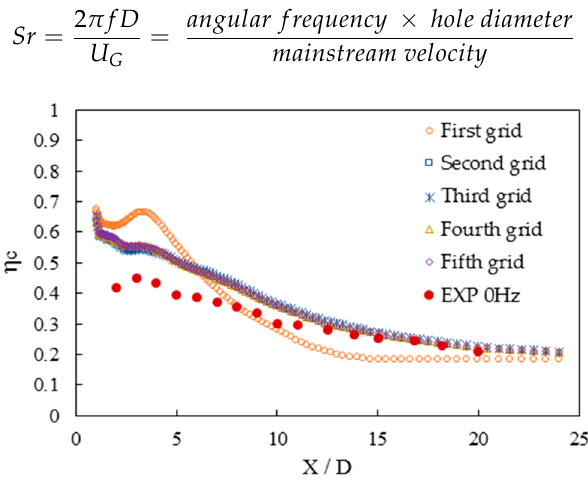
Figure 8. The grid Sensitivity Study for the LES calculation. Table 2. The specifications of grid arrangements in the cross-flow block for the grid sensitivity study. Grid